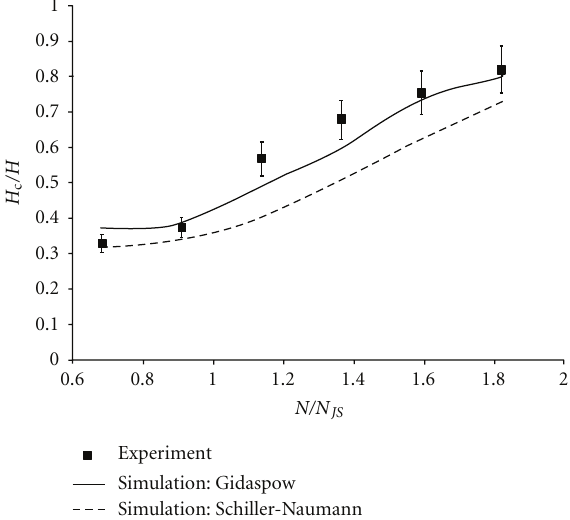
Figure 7: E ff ect of drag model. Plot of normalized cloud height against normalized impeller speed for 15% (w/w) loading and